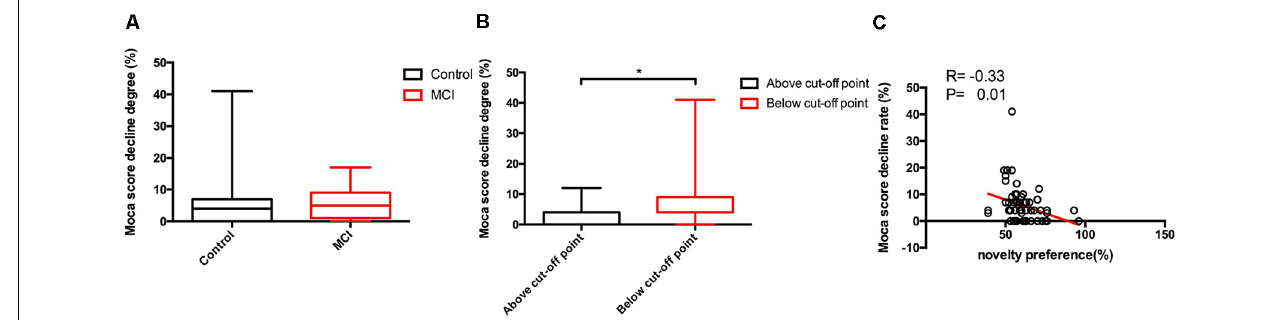
FIGURE 5 | Between-group comparisons of cognitive scores decline degree of different group and the correlations between eye-tracking parameters and cognitive scores decline degree. Only significant findings are shown. Control, normal elderly; MCI, mild cognitive impairment; MoCA, Montreal Cognitive Assessment. Data are expressed as mean ± SD. (A) No significant differences of the decline degree of Moca scores in 1 year follow-up were found between control and MCI group. (B) Significant differences of the decline degree of Moca scores in 1 year follow-up were apparent between above cut-off point and below cut-off point group. (C) The novelty preference scores assessed by eye tracking system showed a negative correlation with the decline degree of Moca scores in 1 year follow-up. * p <